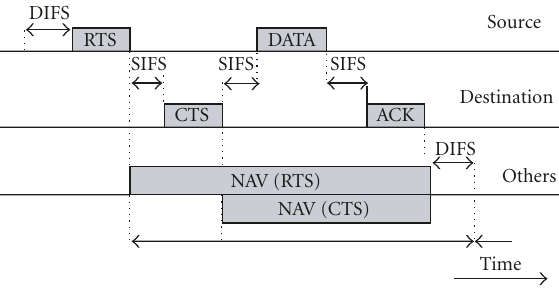
Figure 5: RTS/CTS frame structure.